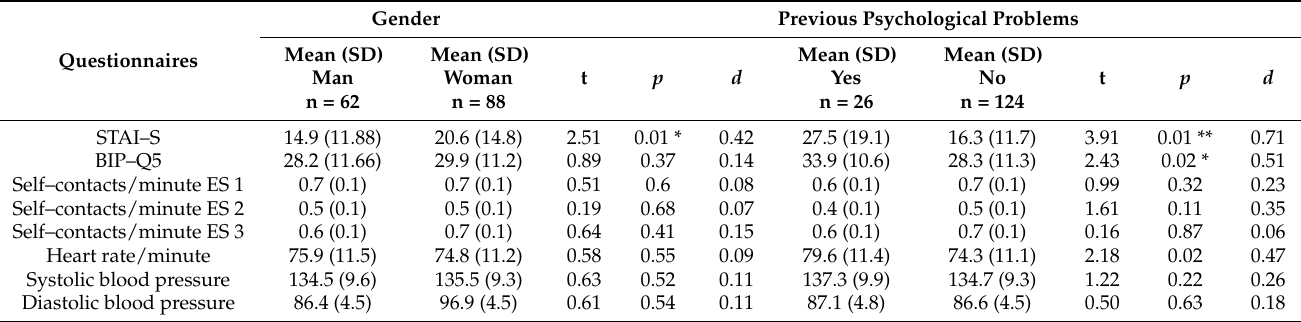
Table 2. Differences in Gender and previous psychological problems (anxiety and depression) for STAI–S, BIPQ–5 and self–contact in the different experimental